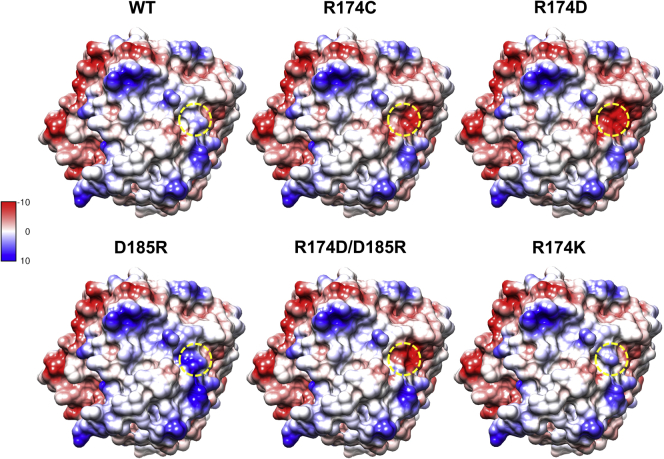
Electrostatic surfaces charges are disrupted by R174C-SR-BI. Arg-174 in WT-SR-BI (top, left) was mutated to cysteine (top, middle) and each of the additional mutants using Chimera software. A top down view of the SR-BI homology model is shown with surface electrostatic coloring, ranging from more negative [red, −10 kcal/(mol ∗ e)] to more positive [blue, 10 kcal/(mol ∗ e)]. The region where Arg-174 occupies and the corresponding regions for R174C-SR-BI and the additional mutants are highlighted in yellow circles. SR-BI, scavenger receptor class B type I.